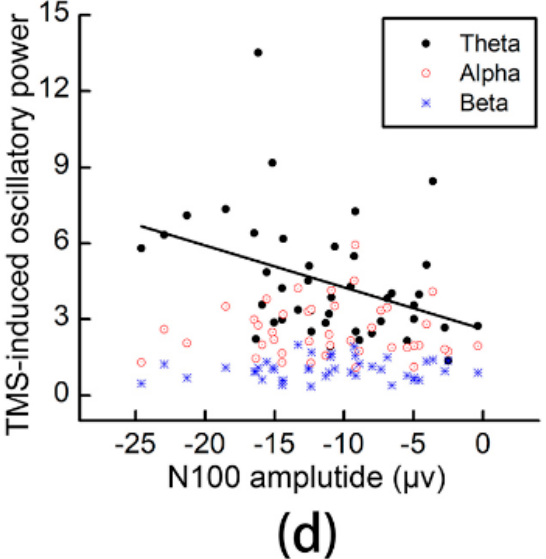
Figure 6. Relationship between the N100 amplitude of M1 TEPs and TMS-induced oscillations. ( a – c ) Correlation coefficients between the N100 amplitude of M1 TEPs and TMS-induced early θ -, α -, and β -band synchronization. “*” represents electrodes with significant correlation. ( d ) Scatter plots of the relationship between oscillations and the N100 amplitude of a representative electrode (Cz). TMS: transcranial magnetic stimulation.